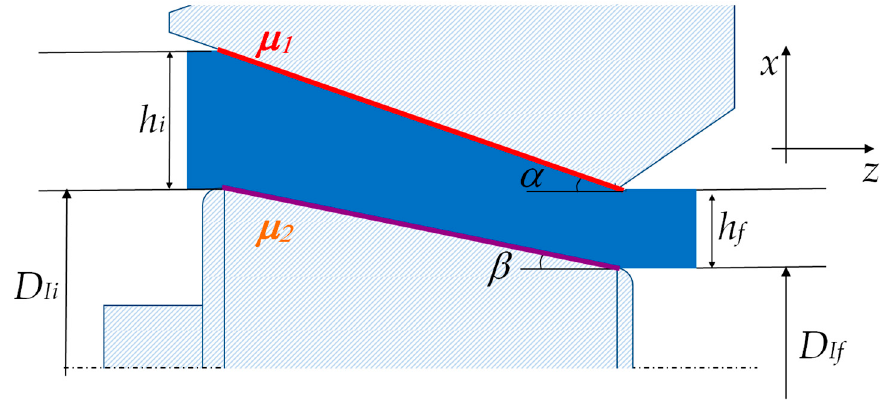
Figure 2. Detail of the plastic deformation zone.